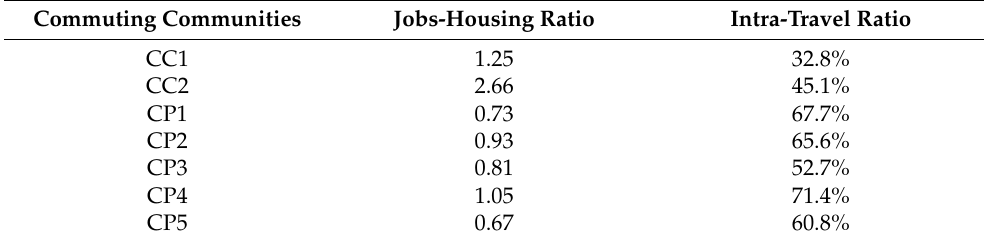
Table 6. The jobs–housing ratio and the intra-travel ratio of commuting communities in Tianjin central